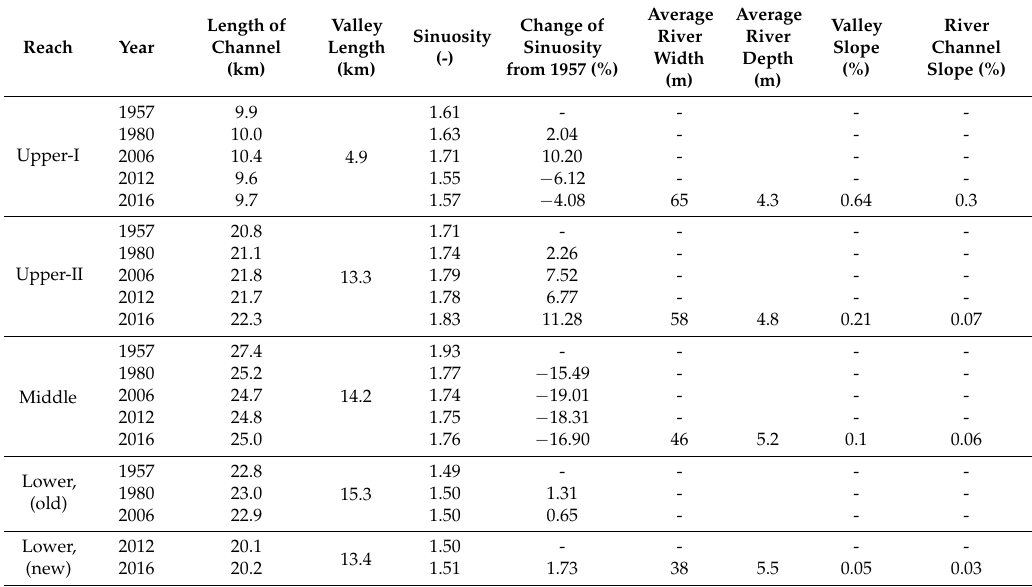
Table 2. Reach-scale planimetric and geometric characteristics of Ribb